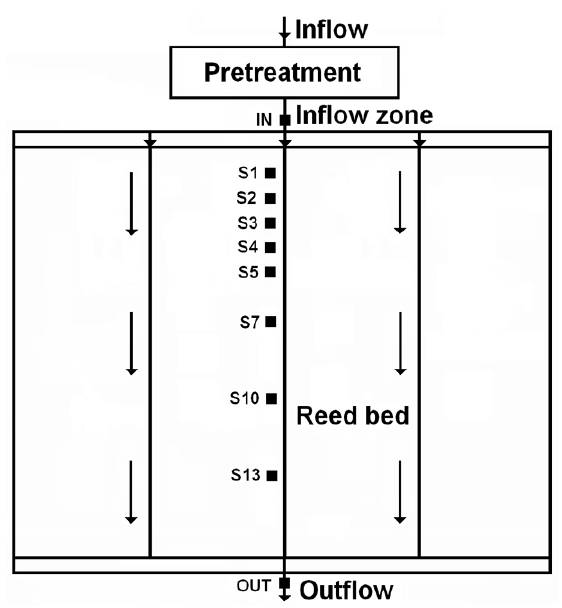
Figure 1. Scheme of the constructed wetland reed bed with the pretreatment